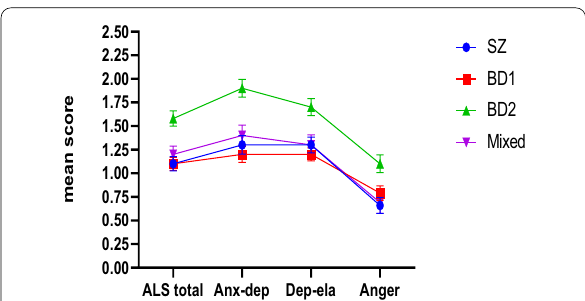
Fig. 1 ALS-SF mean and SEM scores. SEM standard error of the mean, SZ schizophrenia, BD bipolar disorder, ALS-SF affective lability scale short form, anx-dep anxiety-depression domain, dep-ela depression-elation domain